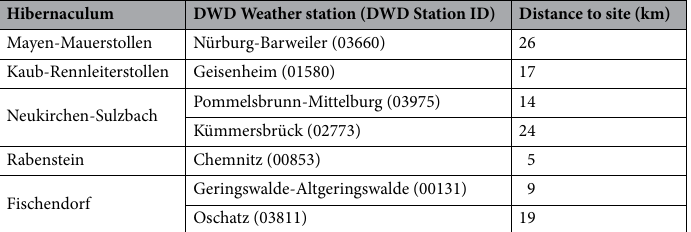
Table 3. Weather stations considered for each hibernaculum and distance between weather stations and hibernaculum.